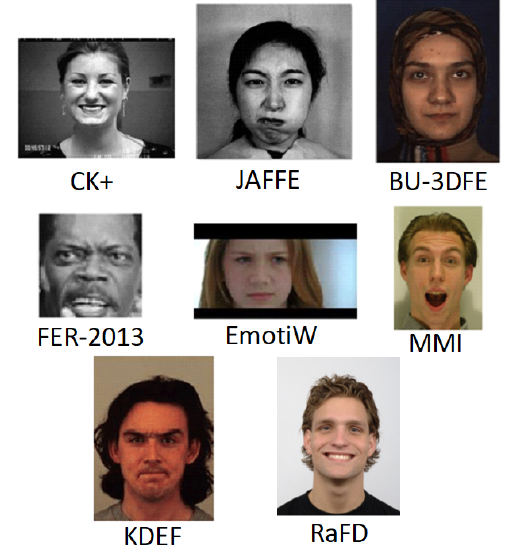
Figure 4. Examples of the introduced FER databases [50–58].